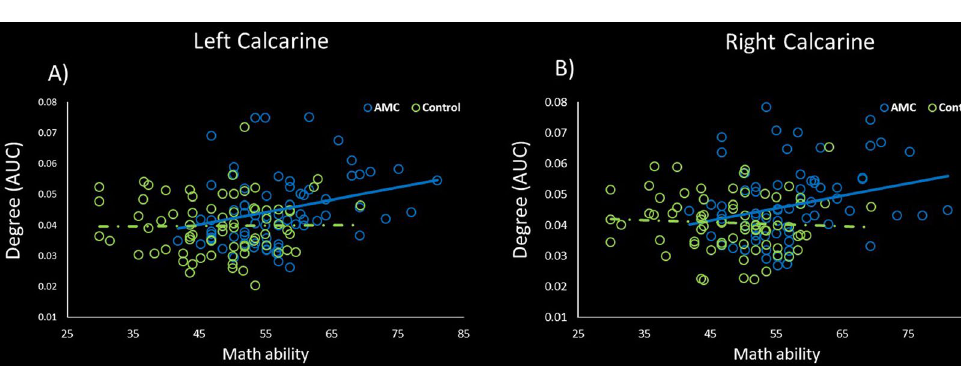
Figure 5. Relationship between math ability and nodal degree in bilateral calcarine sulcus. In the AMC group, significant positive relationship was observed (right calcarine sulcus: r = 0.27, p = 0.02; left calcarine sulcus: r = 0.27, p = 0.02), while no correlation was found in the control group (right calcarine sulcus: r = − 0.06; left calcarine sulcus: r = 0.01; p >